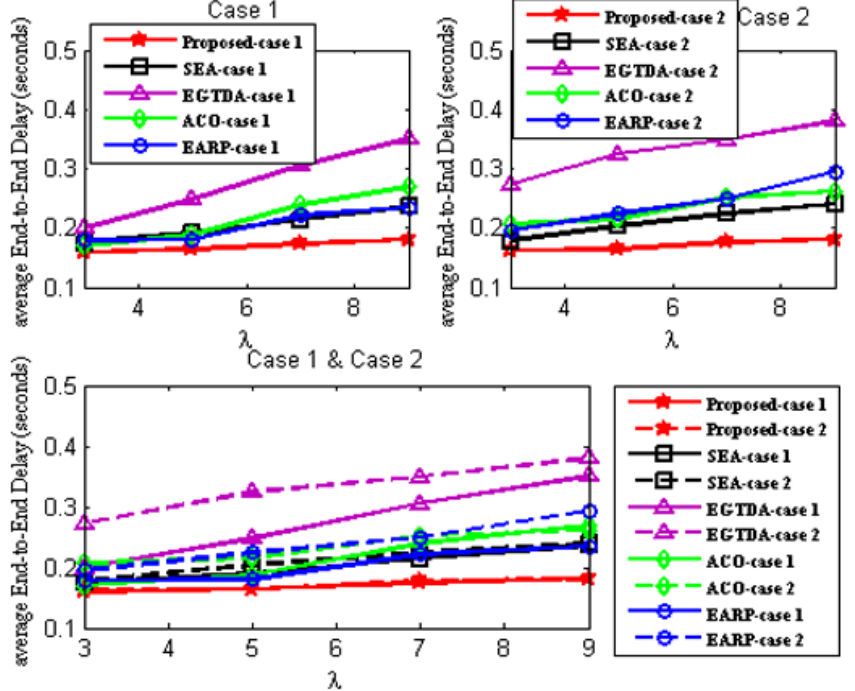
Figure 13. Influence of average traffic rate on average end-to-end delay for the second scenario.